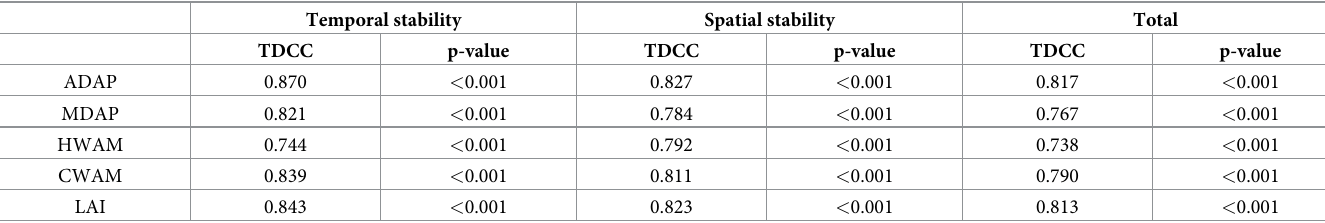
Table 6. Top-Down Concordance Coefficients (TDCC) and related p-values obtained from each sensitivity analysis experiment. Temporal